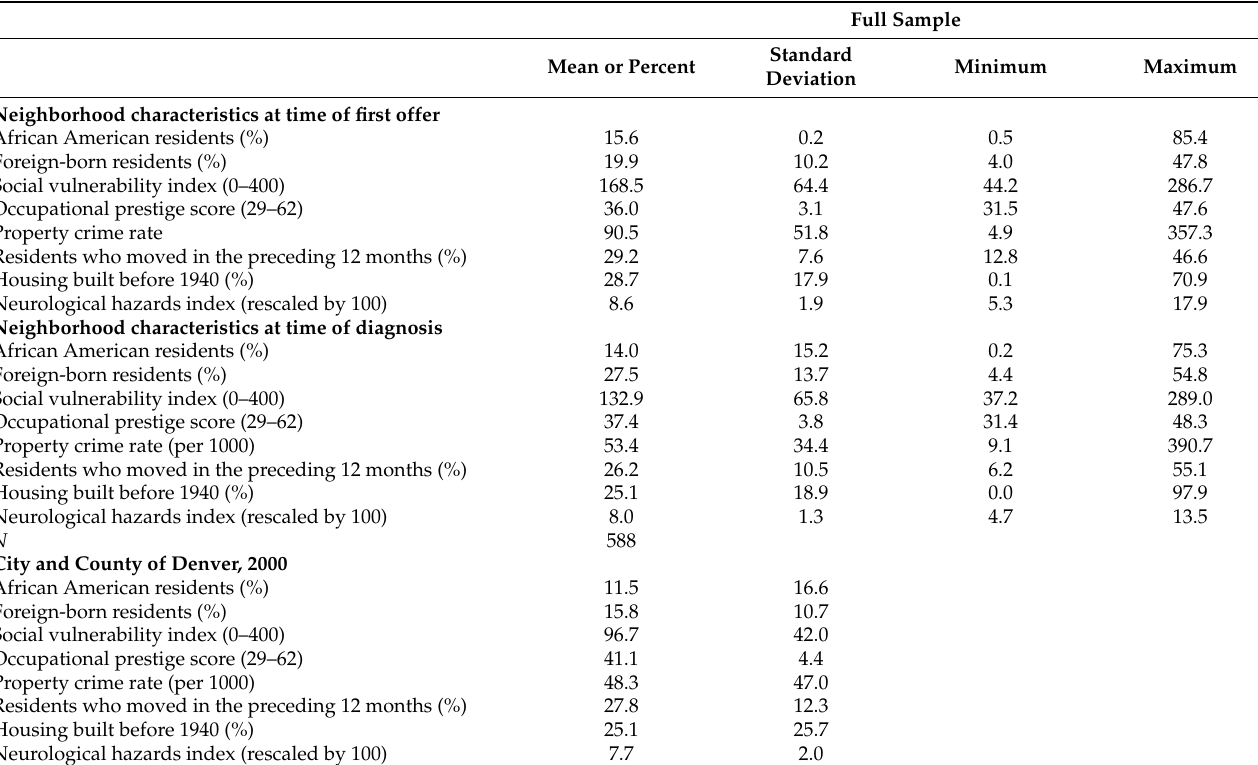
Full Sample Standard Mean or Percent Minimum Maximum Deviation